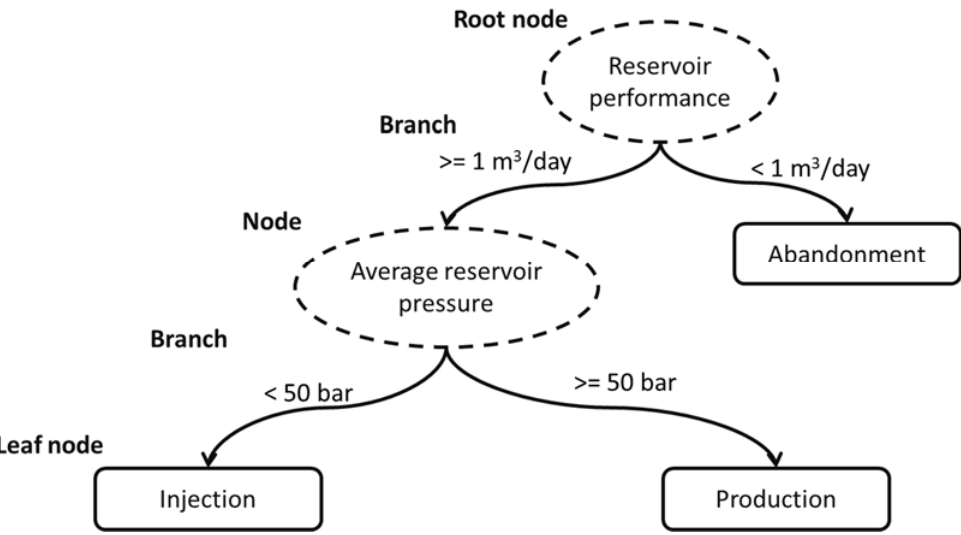
Figure 1. An example of a decision tree with a description of its elements.